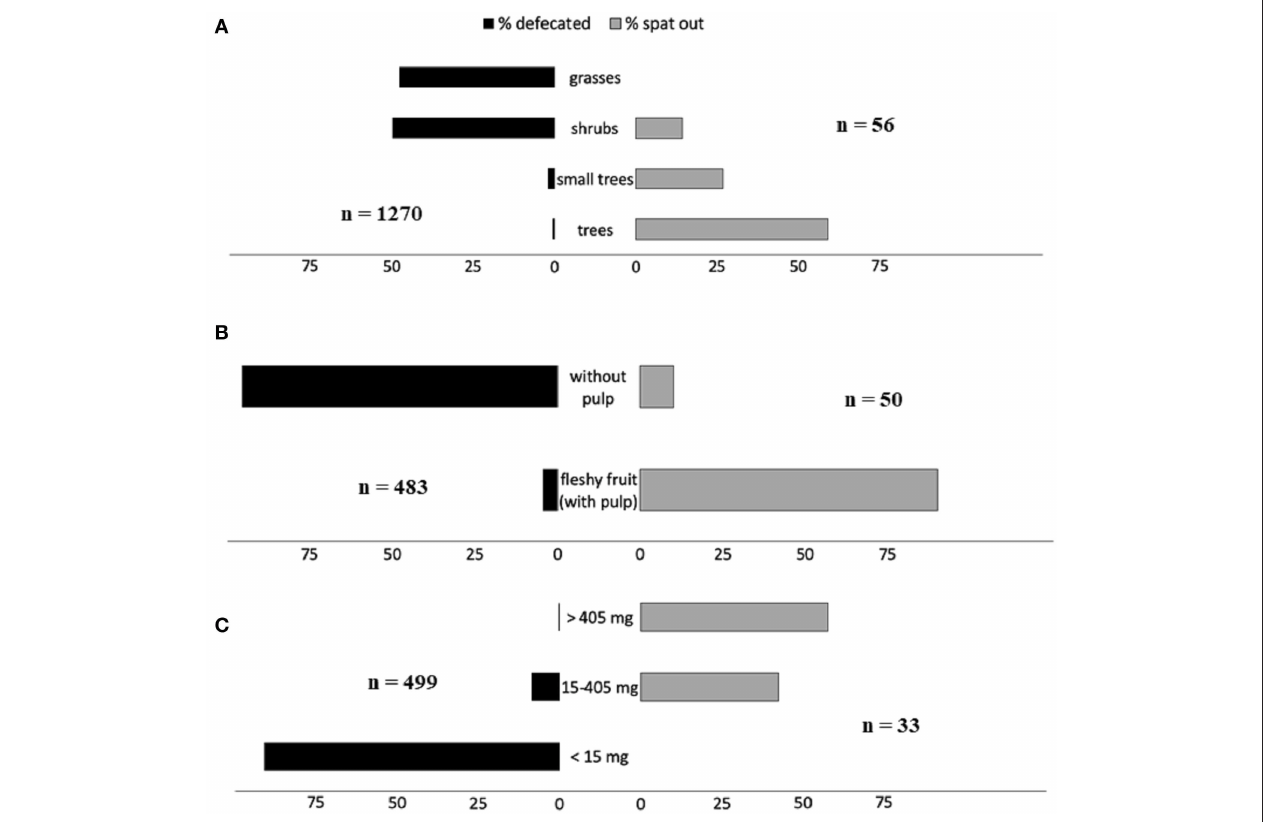
FIGURE 1 | Distribution of frequencies (percentages) of (A) type of plants, (B) type of fruits, and (C) propagule weights, whose seeds are dispersed by ruminant defecation (black bars; data in Albert et al. 2015b, Appendix 5) and spitting from the cud (gray bars; data in this review). Plants under 0.4m in Albert et al. (2015b) were associated with grasses, from 0.4 to 2m to shrubs, from 2 to 5m to small trees and above 5m to trees. Some species were included in several categories (e.g., small trees and